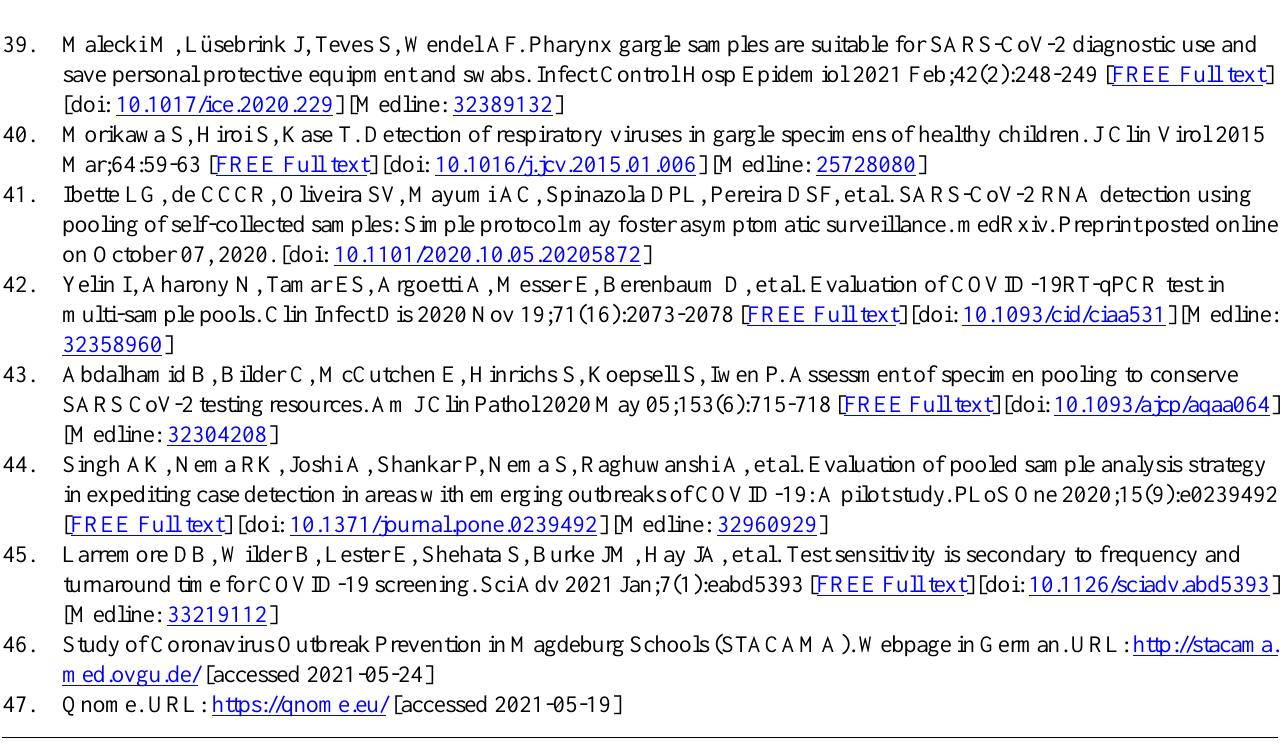
BDSG: Bundesdatenschutzgesetz (Federal Data Protection Act) DSGVO: Datenschutzgrundverordnung (General Data Protection Regulation) EU: European